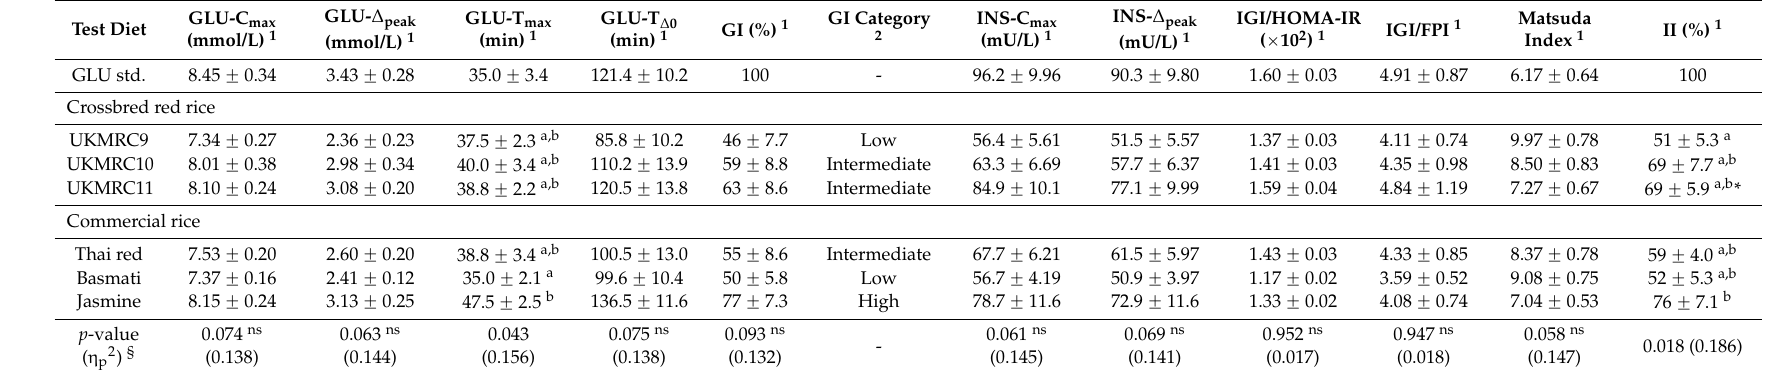
Table 2. Kinetic markers of postprandial glycaemic and insulin